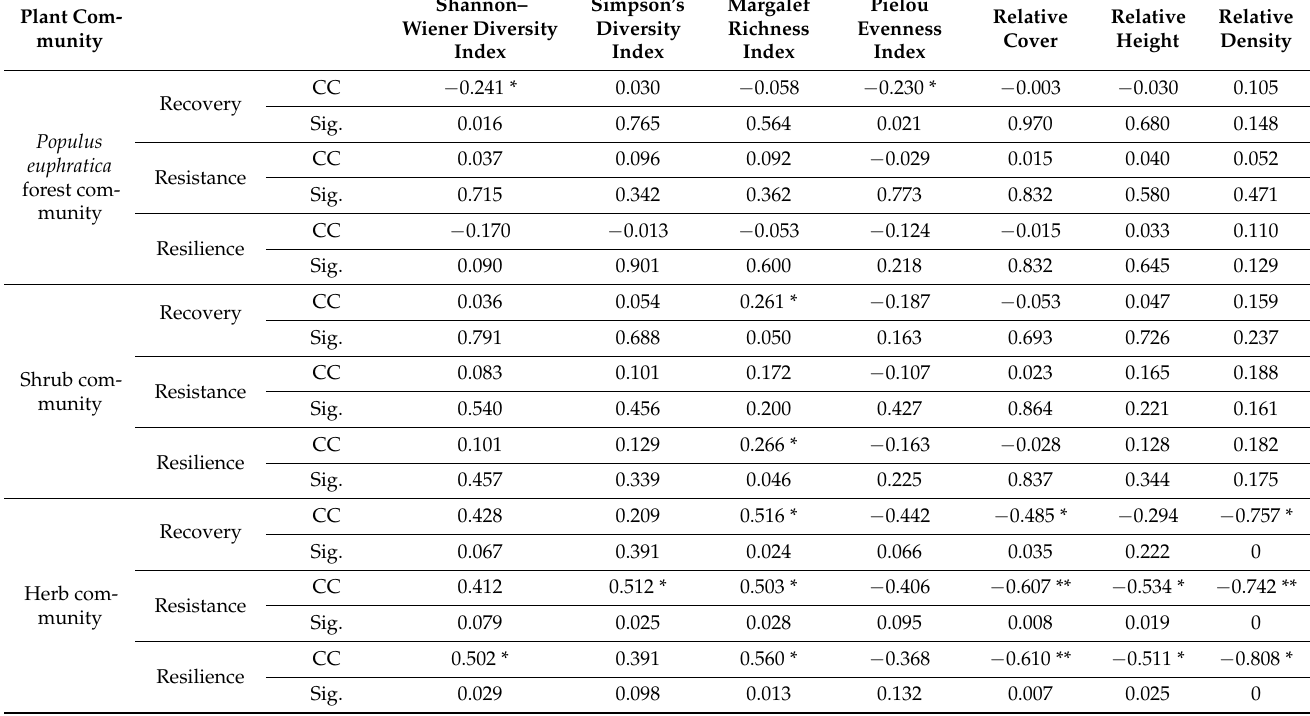
Table 2. Pearson correlation coefficients between the ecological characteristics and recovery and resistance and resilience of the different plant